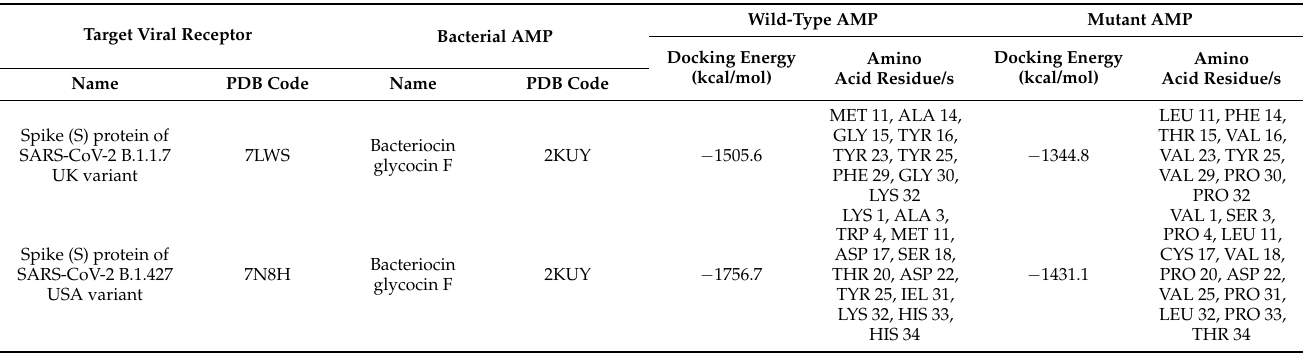
Figure 6. Comparison of wild-type and mutant bacteriocin glycocin F. ( a ) Wild-type bacteriocin glycocin F against the spike (S) protein of SARS-CoV-2 B.1.617.2 Indian variant. ( b ) Mutant bacteriocin glycocin F against the spike (S) protein of SARS-CoV-2 B.1.617.2 Indian variant. ( c ) Wild-type bacteriocin glycocin F against the spike (S) protein of against SARS-CoV-2 P.1 Japan/Brazil variant. ( d ) Mutant bacteriocin glycocin F against the spike (S) protein of SARS-CoV-2 P.1 Japan/Brazil variant. Amino acid residues of the wild-type protein appear in purple, whereas rotamers of amino acid residues of mutant protein appear in gray. Table 13. Comparison of molecular docking analysis of mutant bacterial AMPs with corresponding wild-type